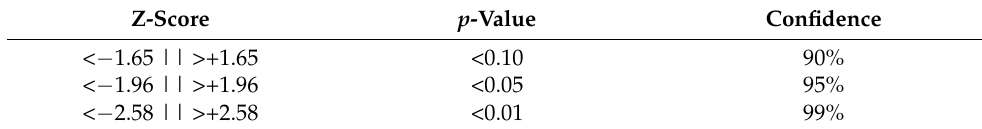
Table 1. The Correspondence between Z-score, p -value and the